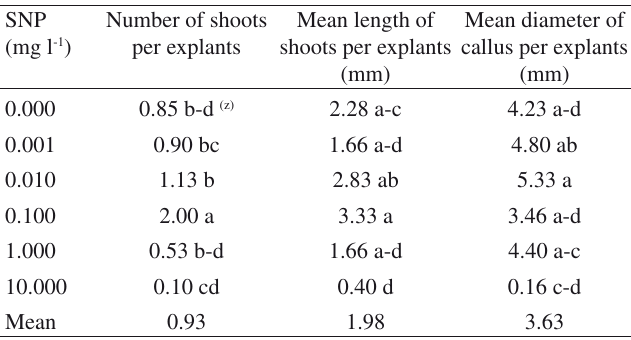
(z) In each column, means with the same letters are not significantly dif- ferent at ≤ 0.05 level of probability using LSD.